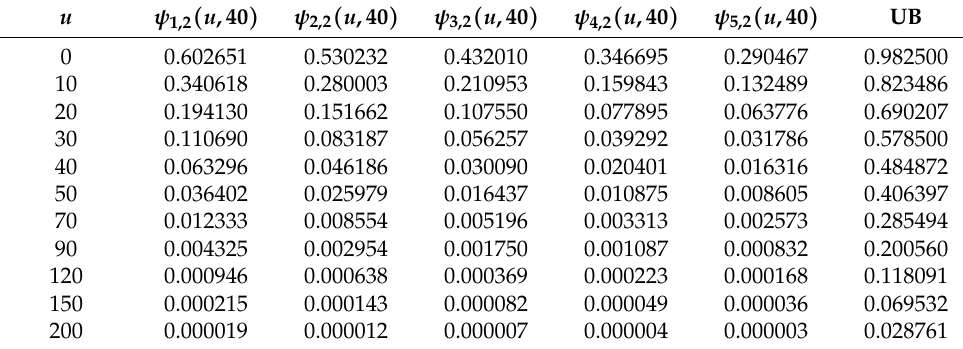
Table 2. ψ i ,2 ( u ,40 ) values with upper bounds